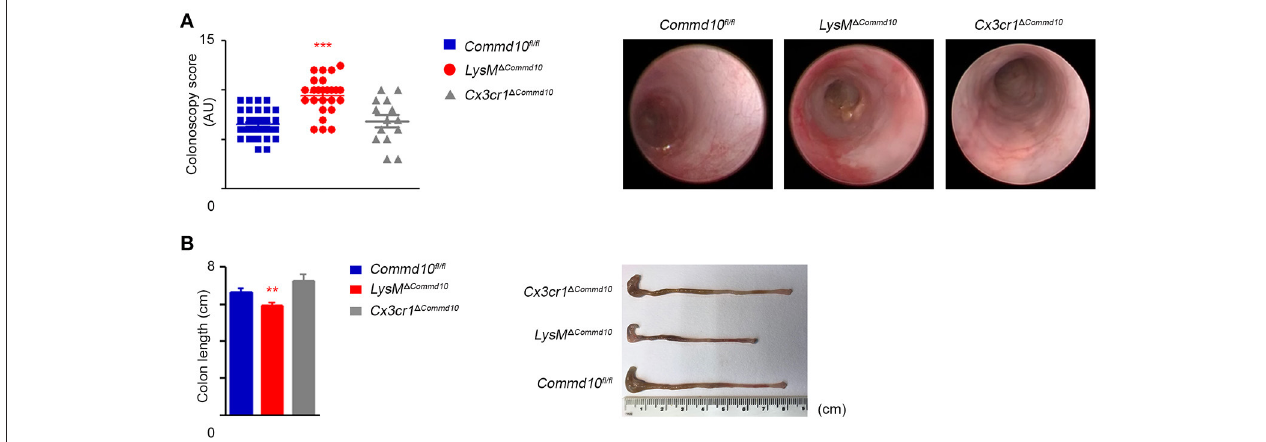
FIGURE 5 | LysM 1 Commd 10 , but not Cx3cr1 1 Commd10 mice exhibit augmented DSS-induced colitis. Commd10 fl / fl (blue), LysM 1 Commd 10 (red) or Cx3cr1 1 Commd 10 (gray) mice were treated with DSS (1.5% in drinking water) for 7 days. (A) Left panel: Scatter plot graph demonstrating colonoscopy scores as determined by live colonoscopy ( n ≥ 14). Right panel: Representative colonoscopy images. (B) Left panel: graph demonstrating colon length. Right panel: Representative colon images ( n ≥ 17 for Commd10 fl / fl and LysM 1 Commd 10 groups, n = 5 for Cx3cr1 1 Commd 10 group) . Data were analyzed by unpaired, two-tailed t -test, comparing each time between one of the mouse groups with Commd10 fl / fl mice (colored stars). Results are presented as mean ± SEM with significance: ** p < 0.01, *** p < 0.001. Data in (A,B) represent 2–3 independent experiments.